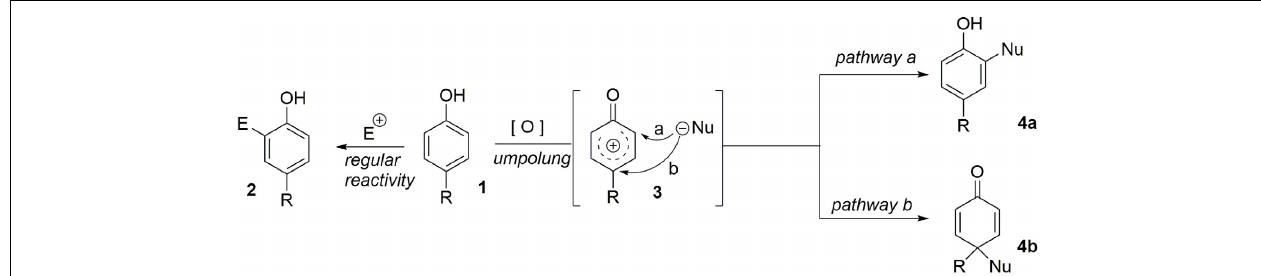
FIGURE 1 | Aromatic ring umpolung concept.